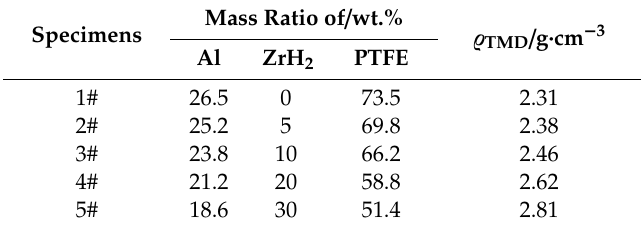
Table 1. Component ratios and theoretical density of the Al / ZrH 2 / PTFE granular composites. Mass Ratio of / Specimens